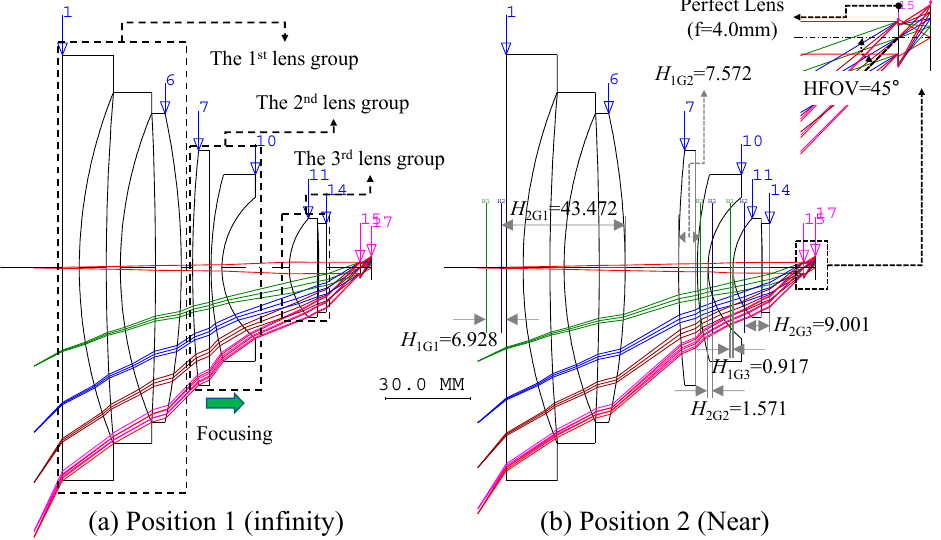
Figure 5. Layout of the aberration-balanced collimator system at infinity (Position 1) and the close position (Position 2).